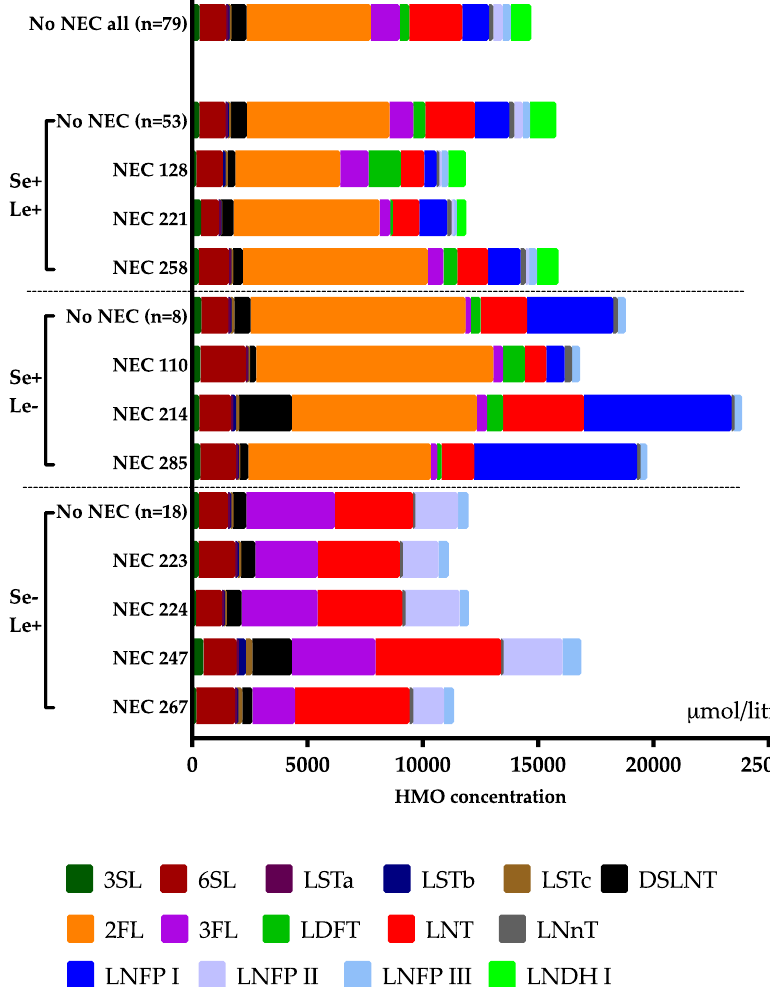
Figure 2. Human milk oligosaccharide (HMO) content in the first breast milk sample from mothers of all NEC-cases, stratified according to secretor (Se) and Lewis (Le) status, and median HMO levels in milk samples from day 14 from the non-NEC cases of the respective Se/Le groups